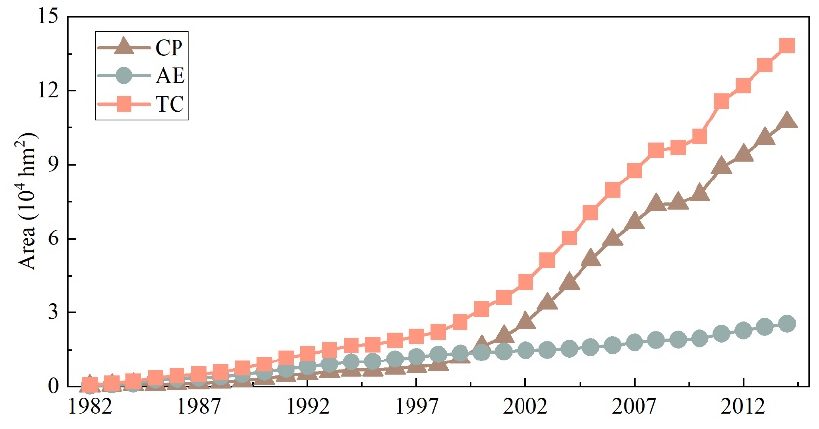
Figure 5. The accumulated SWC measures area from 1982 to 2014.